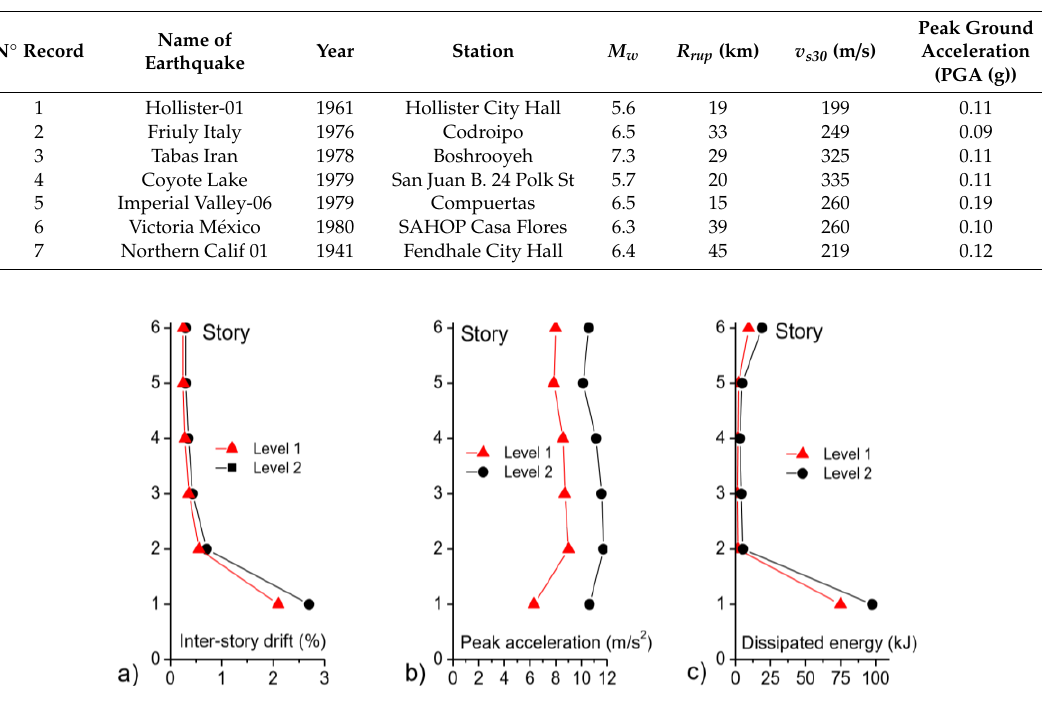
Table 3. Characteristics of ground motions.